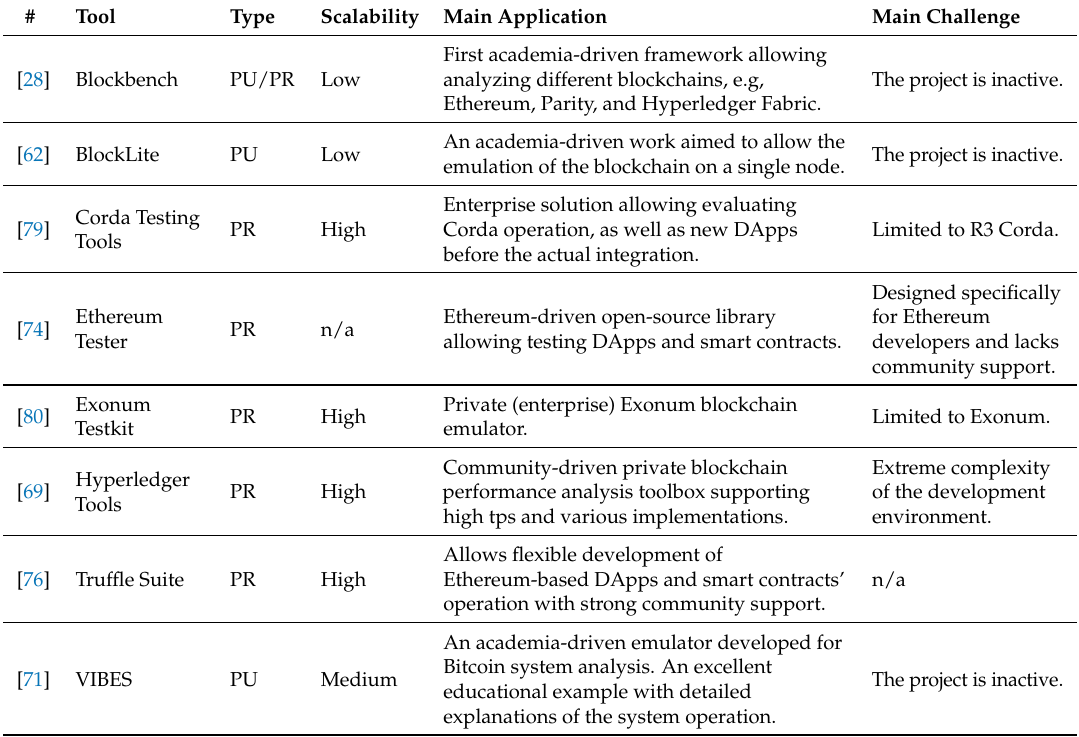
Table 3. Main blockchain emulation tools: PU, Public Blockchain; PR, Private